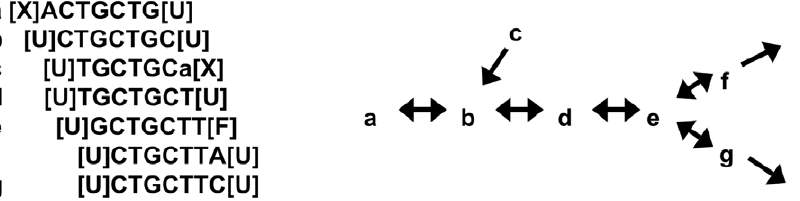
Figure 2. Example of a 7-mer graph. The node a is X-terminated to the left. The non-reciprocal linkage between nodes b and c is removed because the terminal base (lower case ‘‘a’’ in the sequence) of node c is low quality. Node e is F-terminated to the right. The resultant U-U contig is the union of nodes b and d : CTGCTGCT.